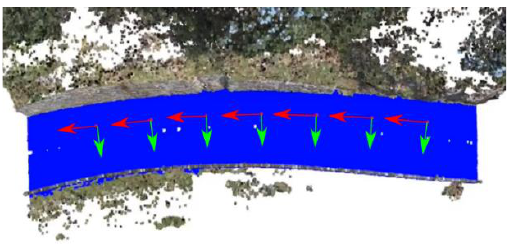
Figure 8. Trajectory direction analysis. Trajectory direction in red. The direction perpendicular to the trajectory in the plane of the roadway in green.